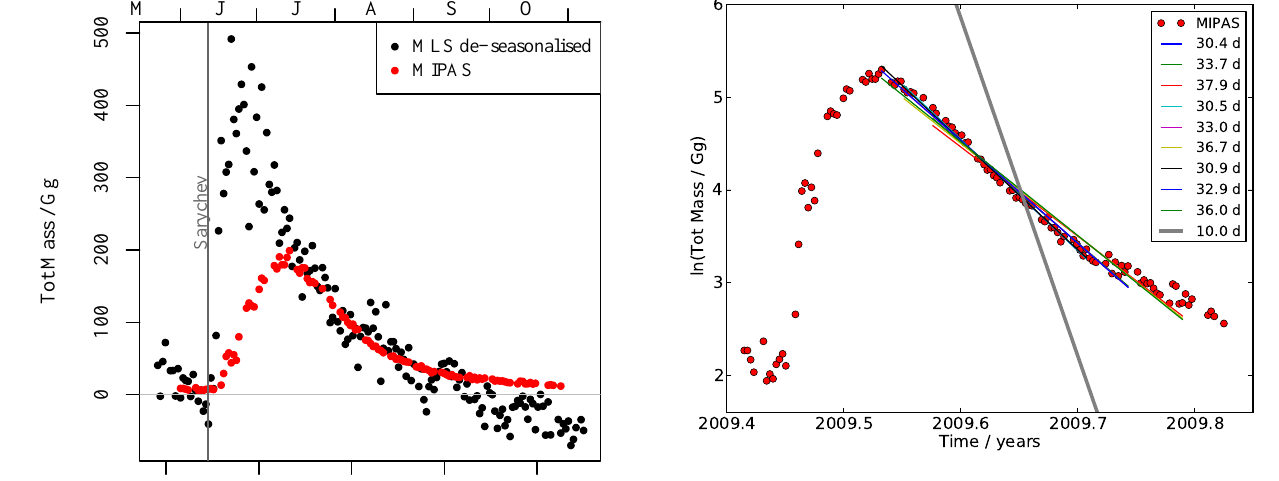
Figure 14. Logarithmic representation of total mass of SO 2 above 146.8hPa from MIPAS (red dots) from Fig. 13 in comparison with e-folding lifetime τ (thin solid lines) resulting from exponential fits using different start/end dates of the fit window. The bold grey line shows a fit with a fixed lifetime of 10